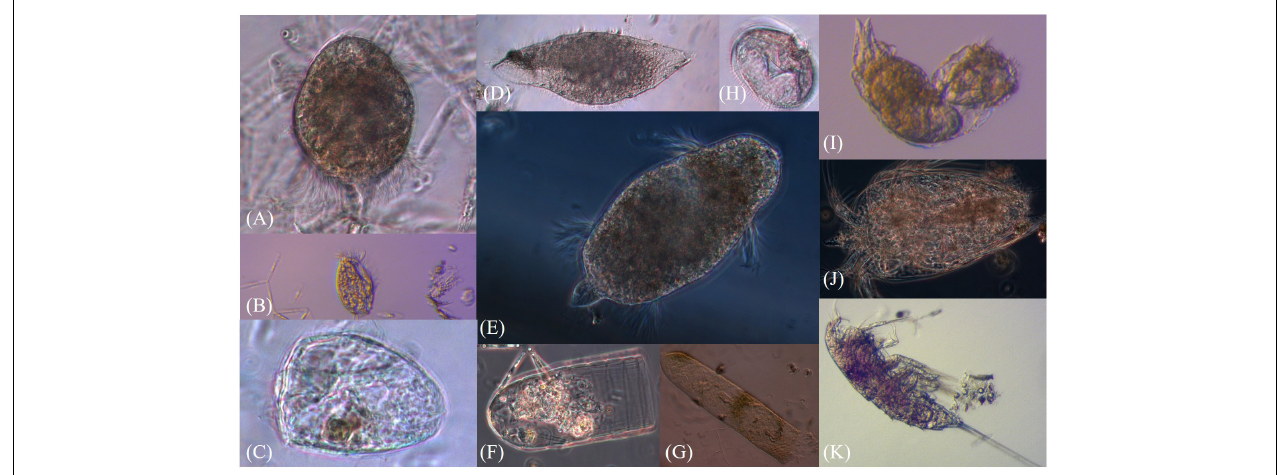
FIGURE 3 | Pictures of sea-ice meiofauna (A–E) Ciliophora, (F,G) Tintinnina, (H) Protoperidinium sp., (I) Rotifera, (J) Nauplius, (K) Harpacticoida. Photographs by Julia Ehrlich.